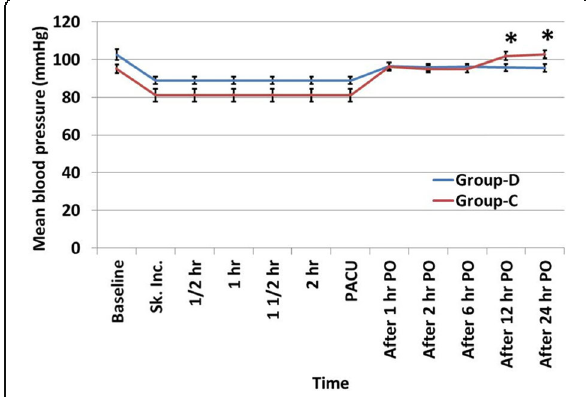
Fig. 2 Comparison between the C group and D group according to mean arterial blood pressure (*significant)